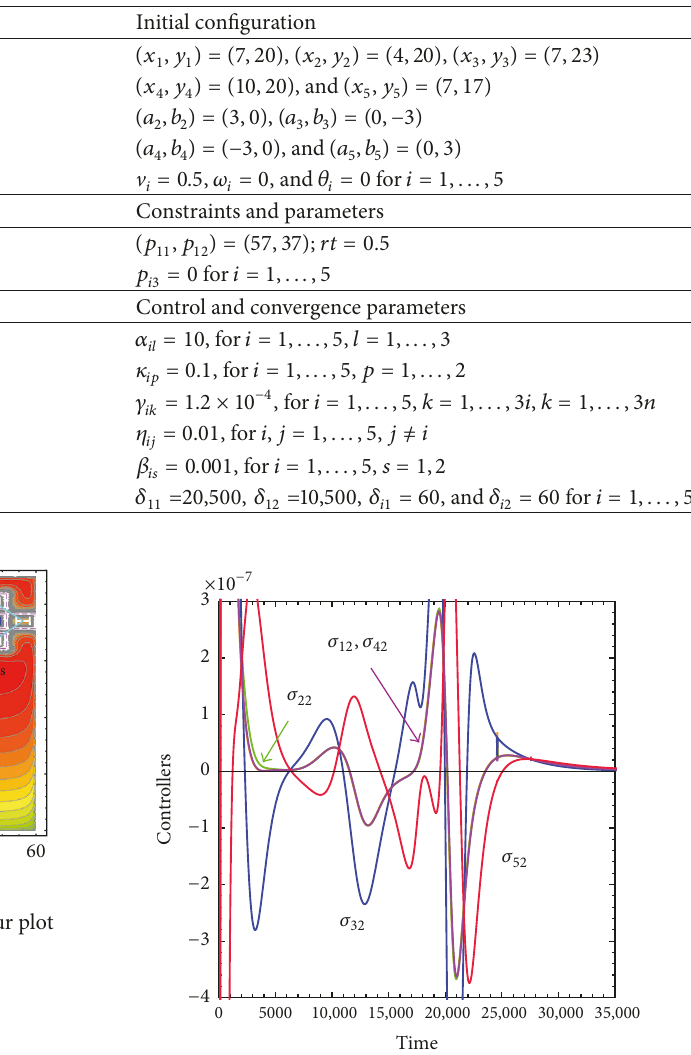
Table 2: Numerical values of initial and final states, constraints, and parameters for Scenario 3.